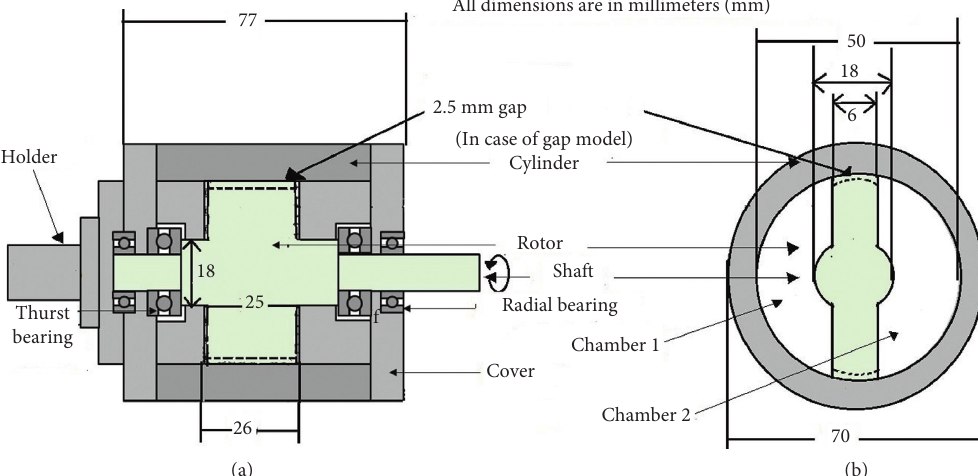
Figure 2: Schematic diagram of the rotary damper with gap and no gap between the rotor and cylinder; all dimensions are in millimeters (mm). (a) Cross-sectional side views of the damper. (b) Cross-sectional top views of the damper.